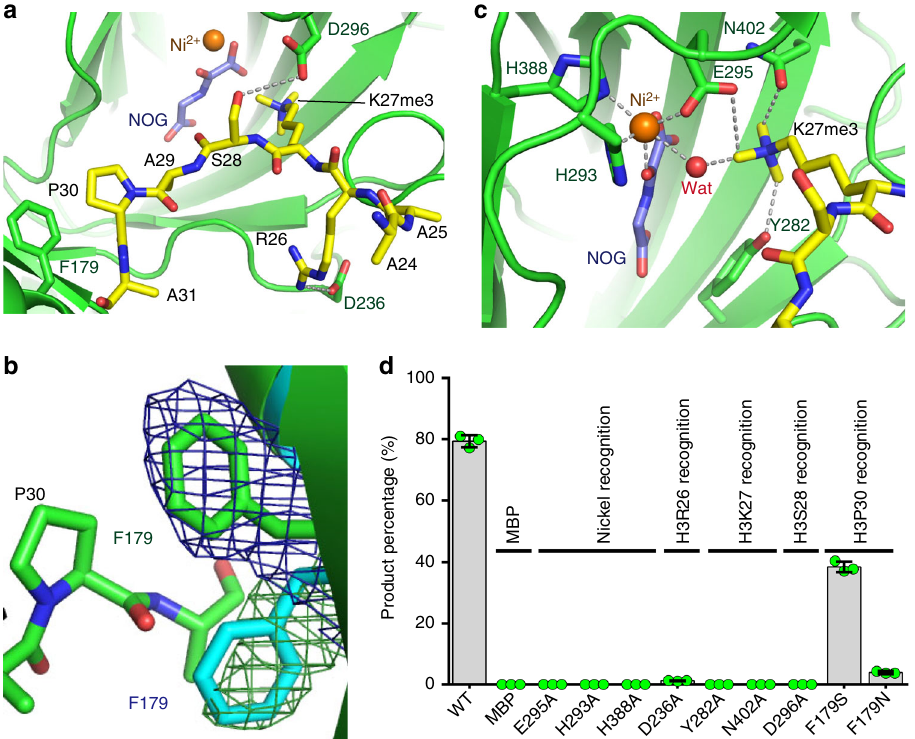
Fig. 3 Structural basis for the recognition of H3K27me3 by JMJ13. a H3R26 and H3S28 form hydrogen bonds (dashed silver lines) with JMJ13 Asp236 and Asp296, respectively. The prolyl ring of H3P30 stacks with the phenyl ring of JMJ13 Phe179. b The superposition of JMJ13- α -KG complex (in cyan) and JMJ13-NOG-H3K27me3 complex (in green) shows that the binding of H3K27me3 peptide induces a signi fi cantly conformational change of the side chain of Phe179. The SIGMAA weighted 2Fo-Fc maps at 1 sigma level of the Phe179 in the two complexes are shown in meshes. c The methyl groups are speci fi cally anchored by surrounding CH – O hydrogen bonds. The nickel ion is coordinated by NOG, a water molecule, and surrounding residues. d In vitro H3K27me3 demethylation activity assay of MBP-tagged JMJ13CD and its mutants showing the mutations of key residues involved in peptide binding and catalysis are decreasing the activity of JMJ13. The MBP protein was used as a negative control. The percentages of the product peptide are shown as means ± SD ( n = 3). Green dots denote the individual data points. Source data are provided as a Source Data fi